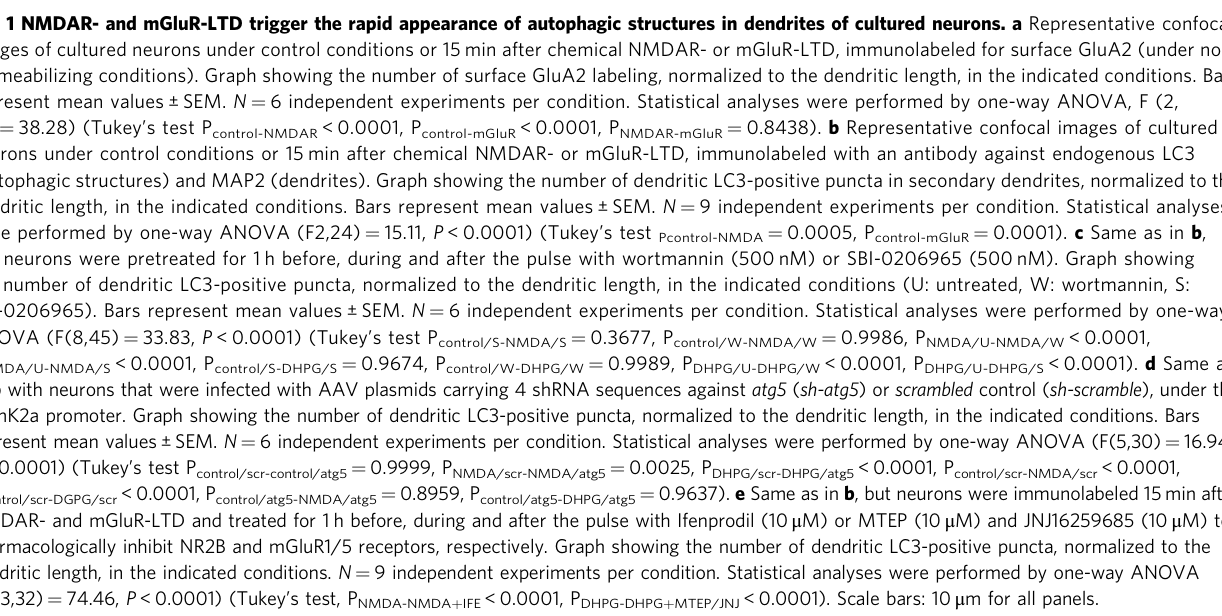
Fig. 1 NMDAR- and mGluR-LTD trigger the rapid appearance of autophagic structures in dendrites of cultured neurons. a Representative confocal images of cultured neurons under control conditions or 15 min after chemical NMDAR- or mGluR-LTD, immunolabeled for surface GluA2 (under non- permeabilizing conditions). Graph showing the number of surface GluA2 labeling, normalized to the dendritic length, in the indicated conditions. Bars represent mean values ± SEM. N = 6 independent experiments per condition. Statistical analyses were performed by one-way ANOVA, F (2, 15) = 38.28) (Tukey ’ s test P control-NMDAR < 0.0001, P control-mGluR < 0.0001, P NMDAR-mGluR = 0.8438). b Representative confocal images of cultured neurons under control conditions or 15 min after chemical NMDAR- or mGluR-LTD, immunolabeled with an antibody against endogenous LC3 (autophagic structures) and MAP2 (dendrites). Graph showing the number of dendritic LC3-positive puncta in secondary dendrites, normalized to the dendritic length, in the indicated conditions. Bars represent mean values ± SEM. N = 9 independent experiments per condition. Statistical analyses were performed by one-way ANOVA (F2,24) = 15.11, P < 0.0001) (Tukey ’ s test Pcontrol-NMDA = 0.0005, P control-mGluR = 0.0001). c Same as in b , but neurons were pretreated for 1 h before, during and after the pulse with wortmannin (500 nM) or SBI-0206965 (500 nM). Graph showing the number of dendritic LC3-positive puncta, normalized to the dendritic length, in the indicated conditions (U: untreated, W: wortmannin, S: SBI-0206965). Bars represent mean values ± SEM. N = 6 independent experiments per condition. Statistical analyses were performed by one-way ANOVA (F(8,45) = 33.83, P < 0.0001) (Tukey ’ s test P control/S-NMDA/S = 0.3677, P control/W-NMDA/W = 0.9986, P NMDA/U-NMDA/W < 0.0001, P NMDA/U-NMDA/S < 0.0001, P control/S-DHPG/S = 0.9674, P control/W-DHPG/W = 0.9989, P DHPG/U-DHPG/W < 0.0001, P DHPG/U-DHPG/S < 0.0001). d Same as in b with neurons that were infected with AAV plasmids carrying 4 shRNA sequences against atg5 ( sh-atg5 ) or scrambled control ( sh-scramble ), under the CamK2a promoter. Graph showing the number of dendritic LC3-positive puncta, normalized to the dendritic length, in the indicated conditions. Bars represent mean values ±SEM. N = 6 independent experiments per condition. Statistical analyses were performed by one-way ANOVA (F(5,30) = 16.94, P < 0.0001) (Tukey ’ s test P control/scr-control/atg5 = 0.9999, P NMDA/scr-NMDA/atg5 = 0.0025, P DHPG/scr-DHPG/atg5 <0.0001, P control/scr-NMDA/scr < 0.0001, P control/scr-DGPG/scr < 0.0001, P control/atg5-NMDA/atg5 = 0.8959, P control/atg5-DHPG/atg5 = 0.9637). e Same as in b , but neurons were immunolabeled 15min after NMDAR- and mGluR-LTD and treated for 1 h before, during and after the pulse with Ifenprodil (10 μ M) or MTEP (10 μ M) and JNJ16259685 (10 μ M) to pharmacologically inhibit NR2B and mGluR1/5 receptors, respectively. Graph showing the number of dendritic LC3-positive puncta, normalized to the dendritic length, in the indicated conditions. N = 9 independent experiments per condition. Statistical analyses were performed by one-way